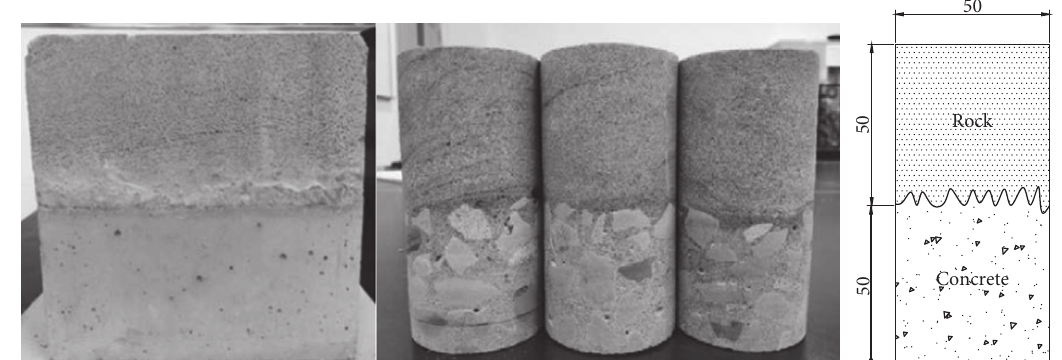
Figure 2: Pictures and schematic diagram of rock-concrete composite specimens.